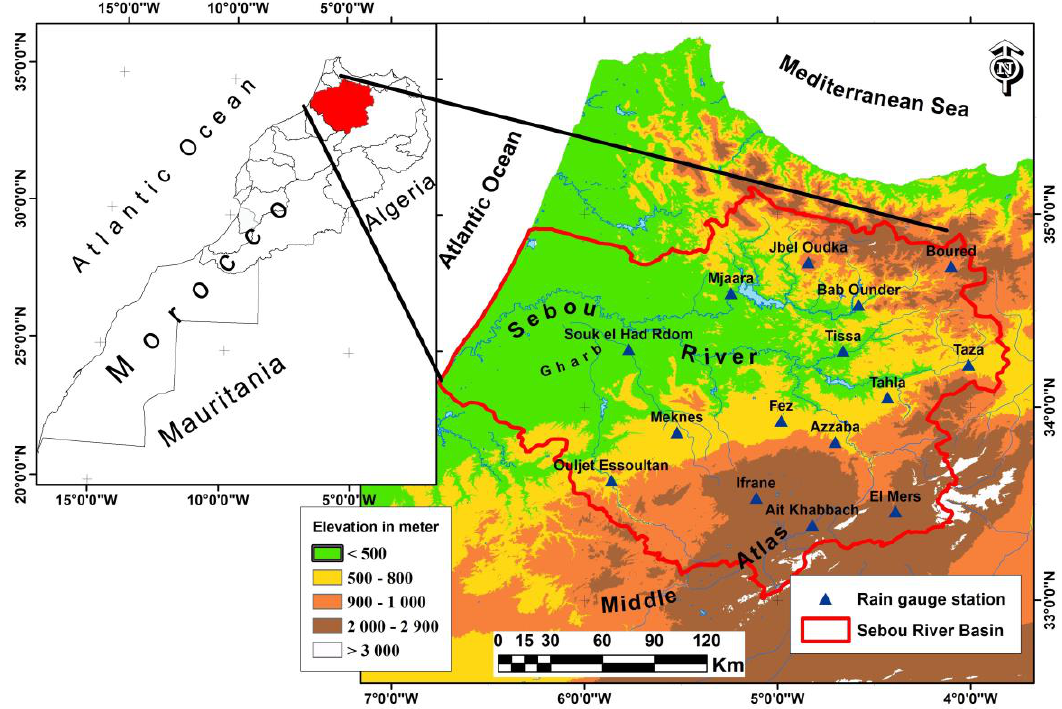
Figure 1. Map of SRB and location of rain gauge stations used in this paper.